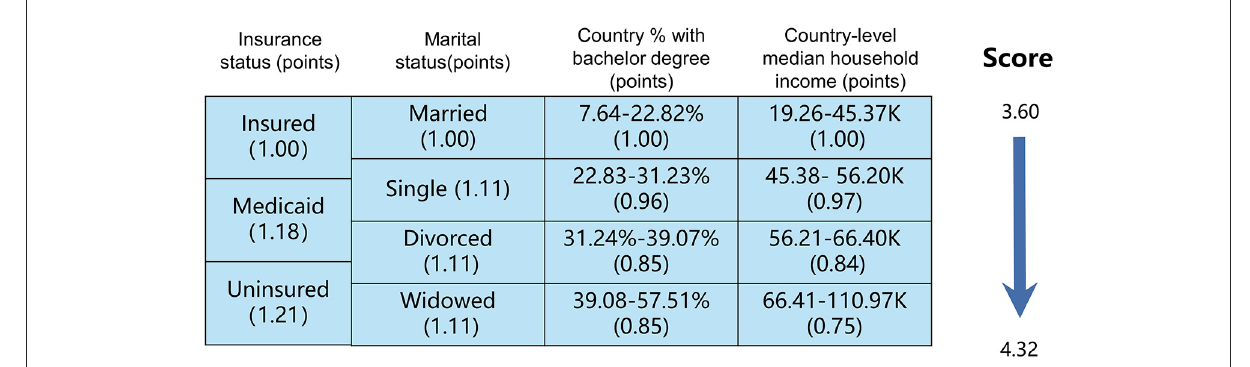
FIGURE1 The socioeconomic status (SES) prognostic scores calculation of the patients with